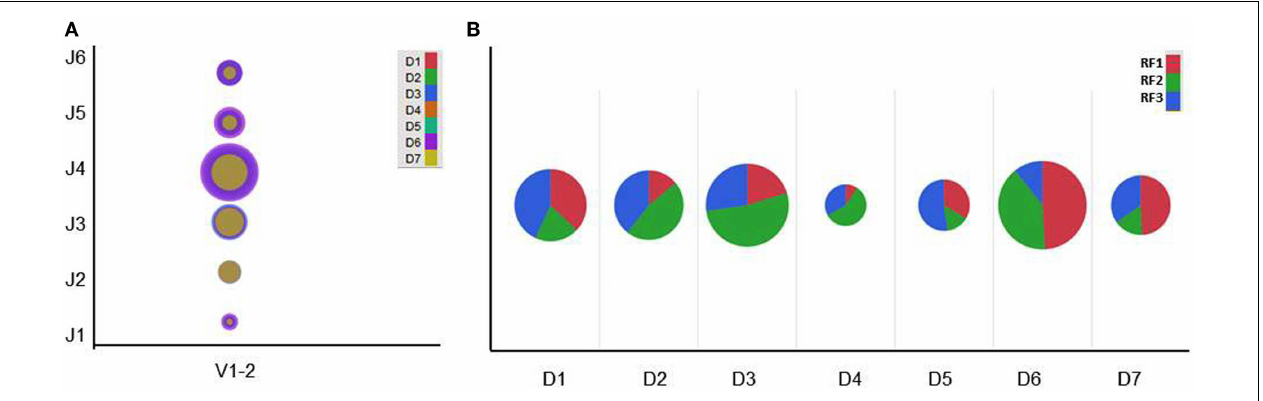
FIGURE 4 | (A) Bubble plot showing theV–D–J diversity associated with IGHV1-2 gene sequences and (B) Pie chart showing the IGHD reading frame (RF) usages in human cord blood IgM library.